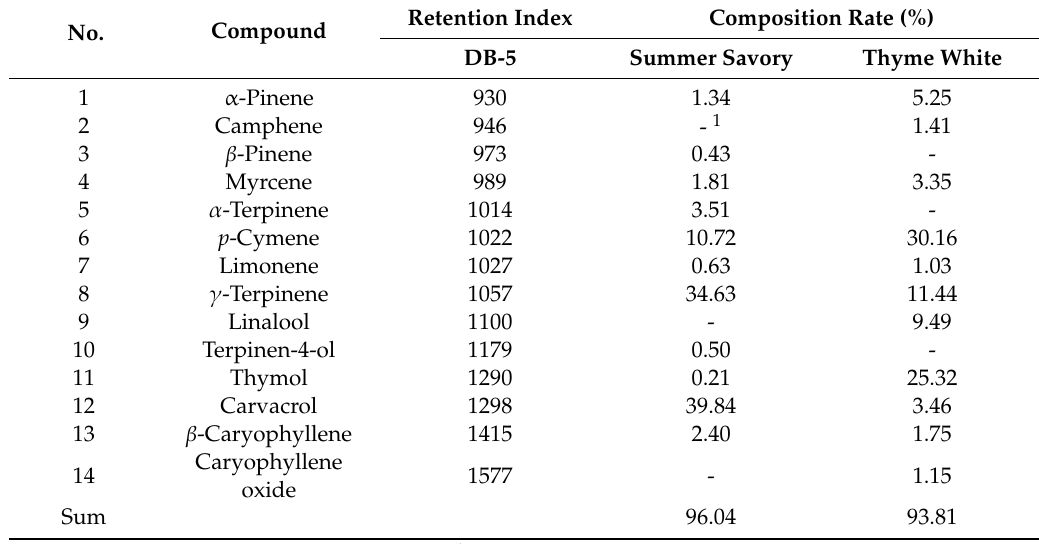
Table 4. Chemical composition of summer savory and thyme white plant essential oils.